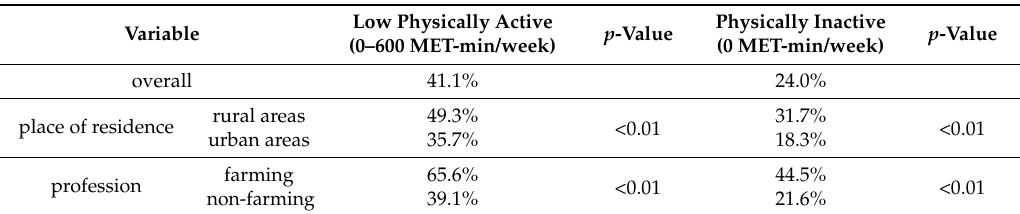
Table 2. Prevalence of low physical activity and physical